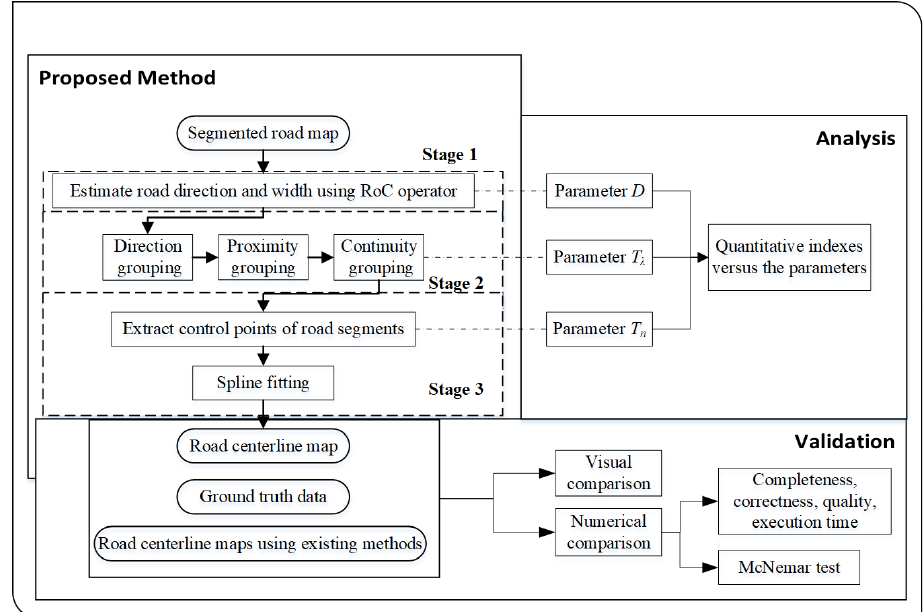
Figure 1. Diagrammatic sketches of the proposed method, validation, and analysis processes.